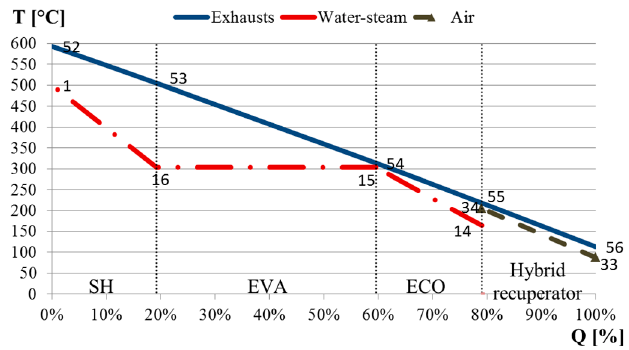
Figure 8. The heat ‐ temperature diagram for HRSG of the SOFC ‐ ST hybrid system. SH = Super Heater, EVA = Evaporator, ECO = Economizer.